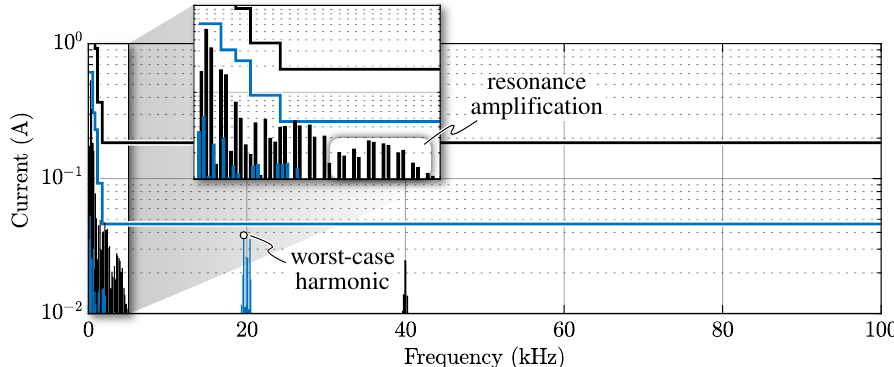
Figure 17. Experimental filtered grid-side current i f spectrum compared with IEEE 519 odd-order (black) and even-order (blue) harmonic limits. The worst-case harmonic at the design frequency is indicated and the amplification effect around the filter resonance frequency f 0 is